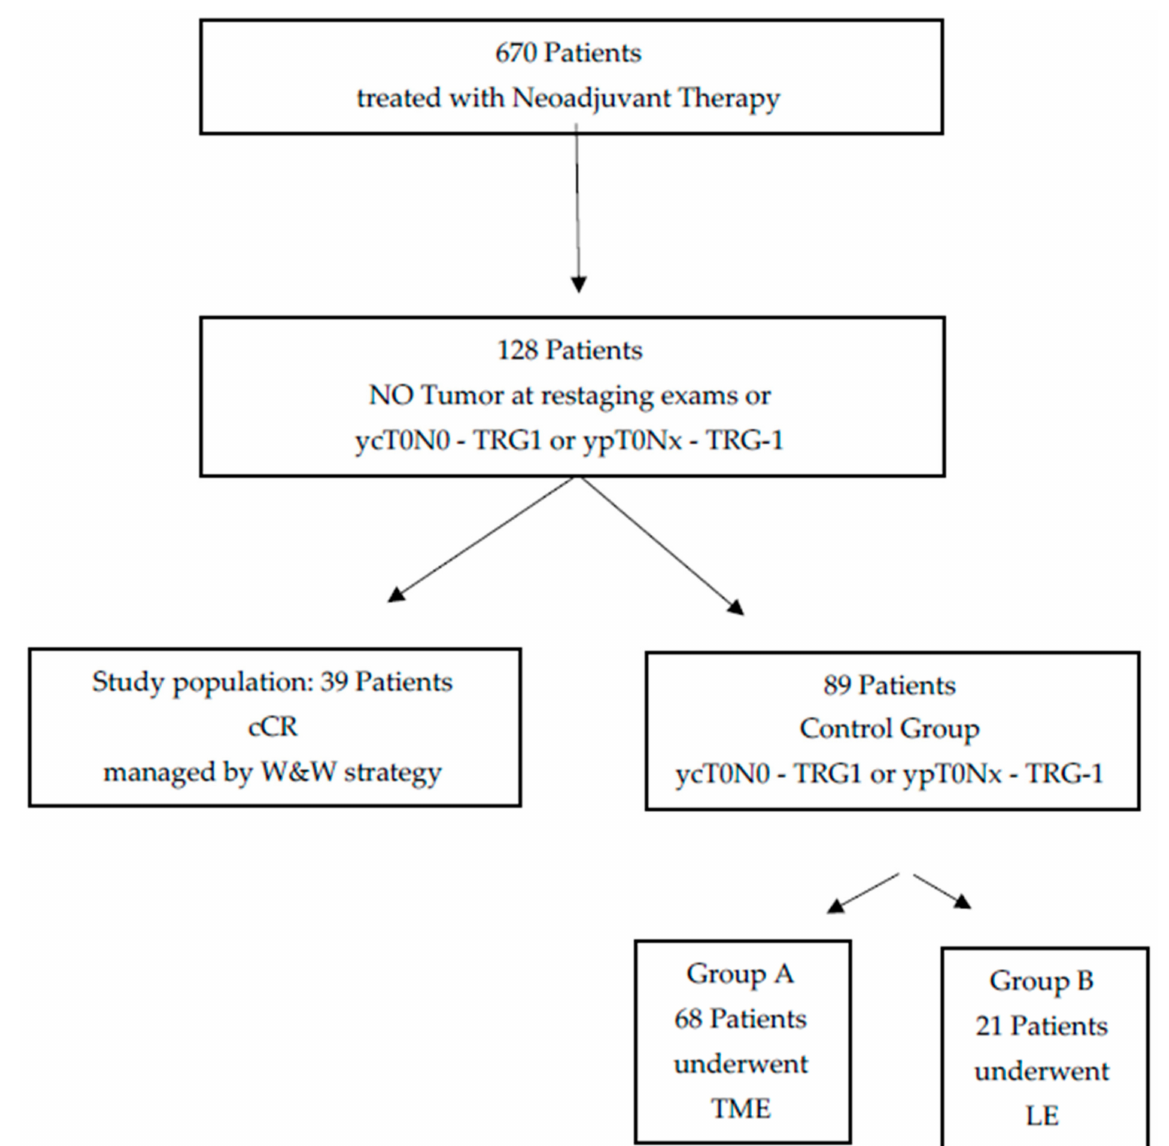
Figure 1. Scheme of groups compositions in this study. The following acronyms are used: clinical complete response (cCR), total mesorectal excision (TME), watch and wait (W&W), local excision